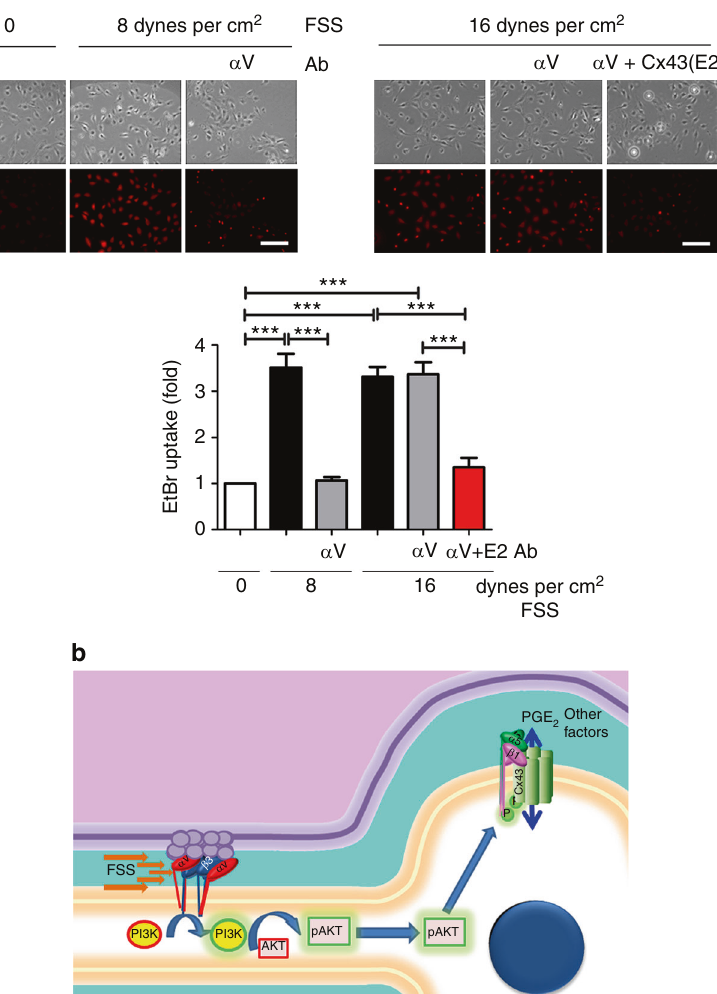
Fig. 6 Integrin α V activation is required for HC opening at low but not high FSS levels. a Inhibition of integrin α V activation prevents HC opening at low but not high FSS levels. MLO-Y4 cells were pretreated with an antibody blocking α V activation ( α V Ab) or an HC-blocking Cx43 (E2) antibody and then subjected to treatment with 8 dynes per cm 2 FSS (upper, left panel), 16 dynes per cm 2 FSS (upper, right panel), left untreated, or treated with a static control; EtBr dye was added. The degree of dye uptake was quanti fi ed (lower panel). Bar, 100 µm. The data are presented as the mean ± SEM. n = 3. ***, P < 0.001. b Mechanotransduction occurs in osteocytes through the functional interplay of integrins and Cx43 HCs. Integrin α V β 3 located at the dendrites of osteocytes as part of tethering elements facilitates the attachment of osteocytes to the canalicular wall, and this unique arrangement ampli fi es the magnitude of FSS experienced by osteocytes. 8,26 FSS through the lacunae-canaliculi network induces the activation of α V β 3, which leads to the activation of intracellular PI3K and subsequent AKT activation. The activation of AKT results in the conformational activation of integrin α 5 β 1. The phosphorylation of Cx43 by AKT and direct interaction between Cx43 and α 5 β 1 open HCs, 23 which allows the release of small molecule bone factors, such as PGE 2 , which are important for bone formation and